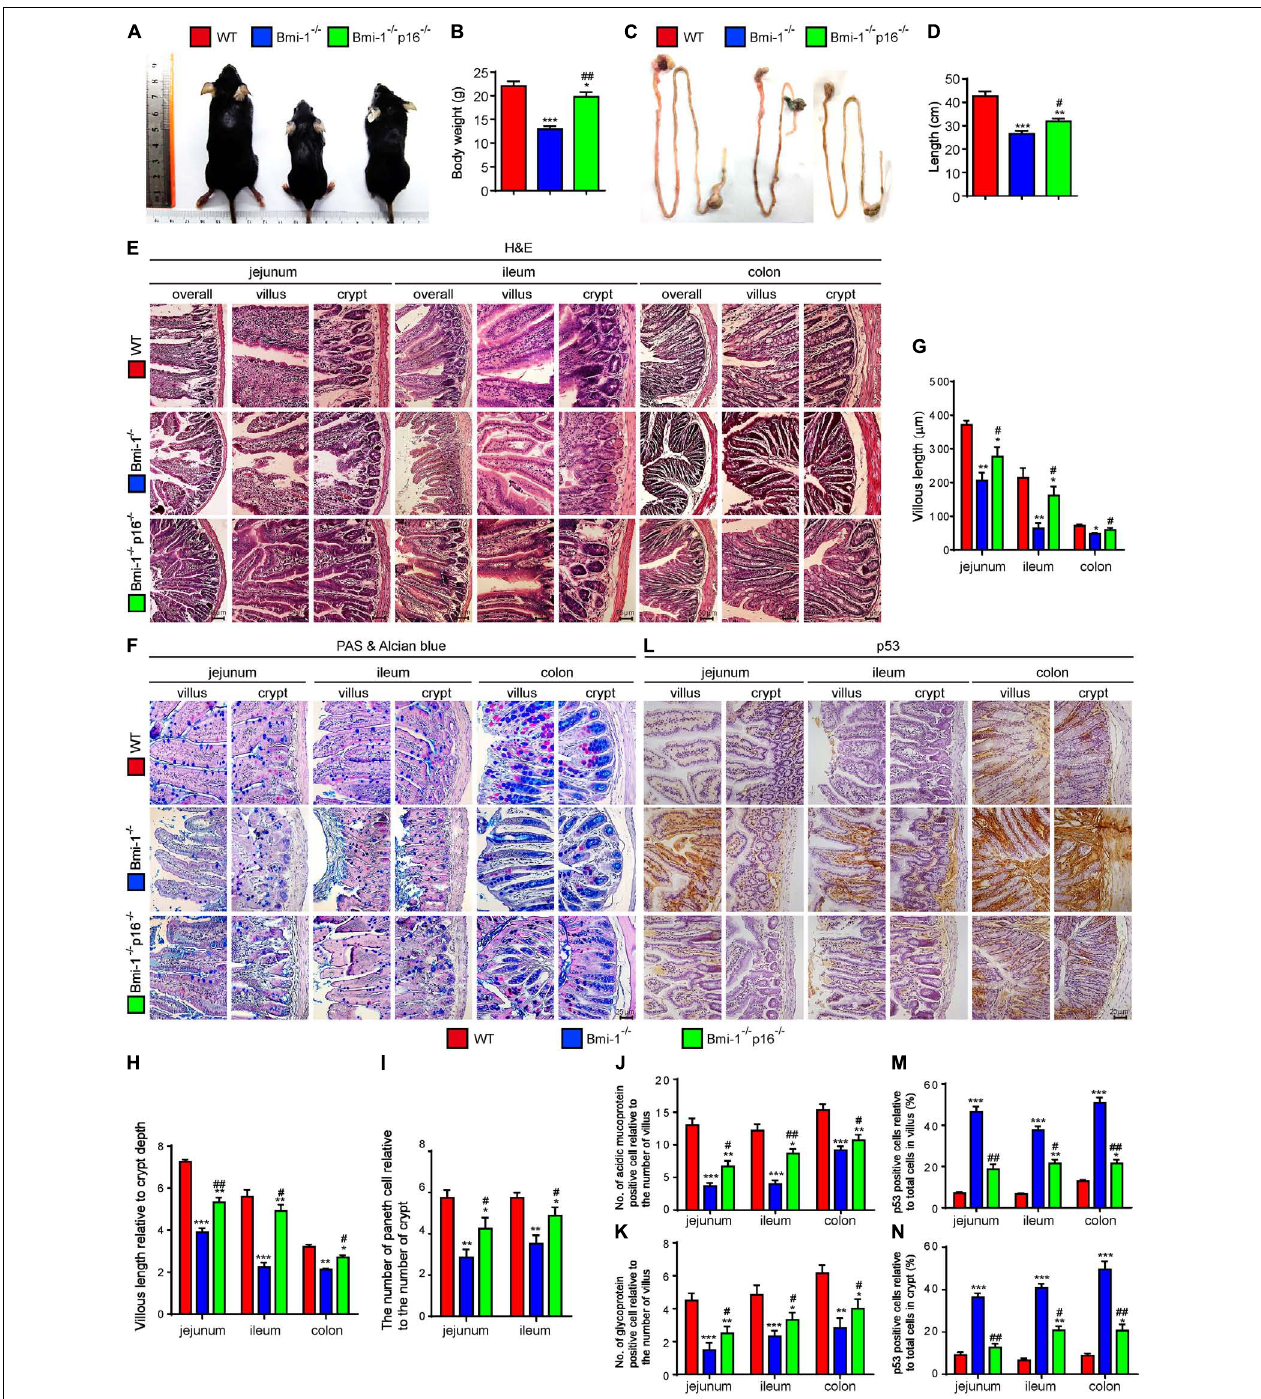
FIGURE 1 | P16 deletion improved damage of barrier structure and dysfunction in intestinal epithelium in Bmi-1 − / − mice. The experiments were carried out on the 7-week-old Bmi-1 − / − , Bmi-1 − / − p16 − / − , and WT mice. (A) Representative appearances. (B) Body weight (g). (C) Whole view of the intestine. (D) Intestinal length (cm). (E,F) H&E and AB-PAS staining of jejunum, ileum, and colon. (G) Villous length ( µ m). (H) Villous length relative to crypt depth. (I) The number of Paneth cells relative to the number of crypts. (J) The number of acidic mucoprotein positive cells. (K) Glycoprotein-positive cells relative to the number of villus. (L) Representative micrographs of paraffin-embedded intestinal sections immunohistochemical staining for p53, with hematoxylin staining the nucleus. (M,N) Percentage of p53-positive cells relative to the total cells. Six mice per group were used for experiments. Statistical analysis was performed with one-way ANOVA test. Values are mean ± SEM from six determinations per group, * p < 0.05, ** p < 0.01, *** p < 0.001 compared with the WT group; # p < 0.05, ## p < 0.01 compared with the Bmi-1 − / − group.